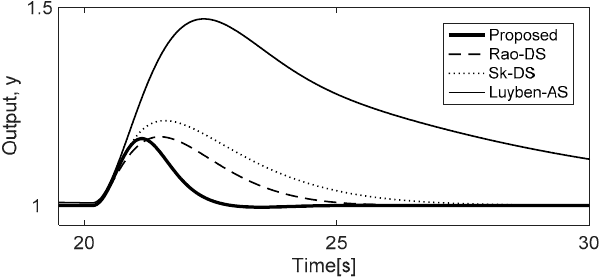
Figure 11. Regulatory responses to disturbance in IFOPTD with − 10% parameter mismatch.